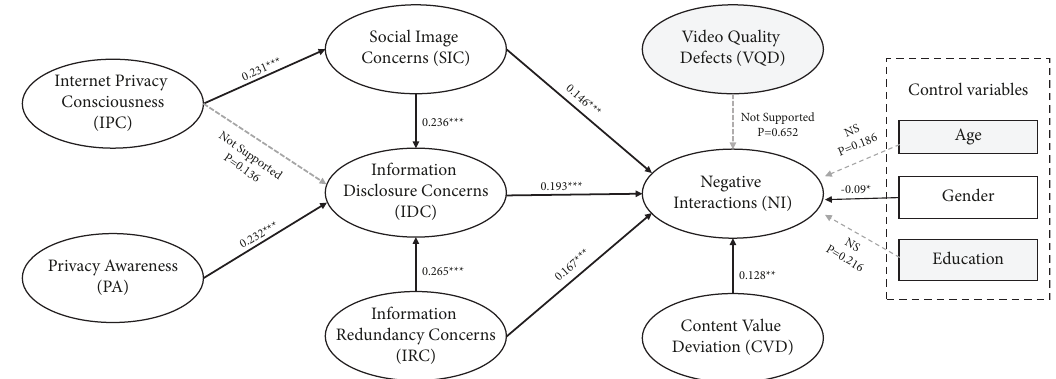
Figure 2: Graphical view of the path analysis of the conceptual